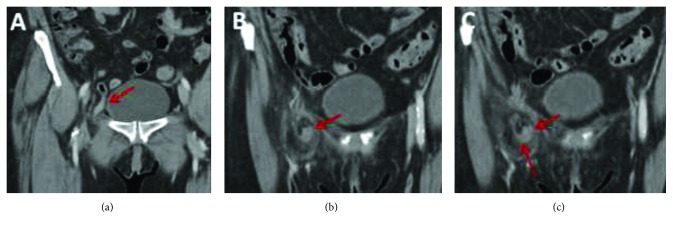
Coronal contrast-enhanced CT images demonstrate the appendix (solid arrows) entering into the right femoral hernia sac with surrounding periappendiceal fat stranding (dashed arrow) in keeping with chronic appendicitis.